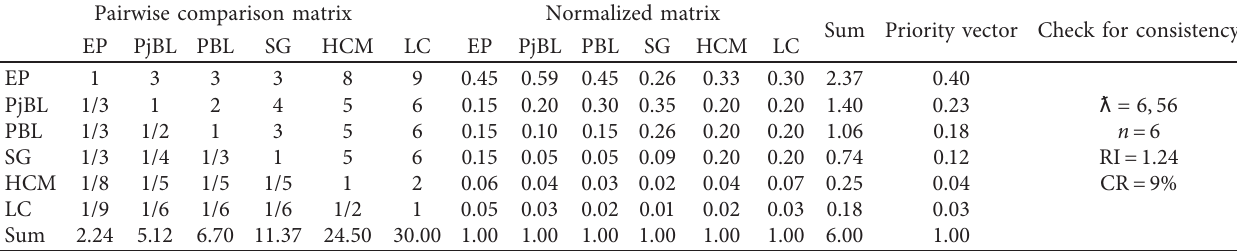
Table 15: Pairwise comparison matrix of learning strategies with respect to the Criterion “SS7. Project management.” Pairwise comparison matrix